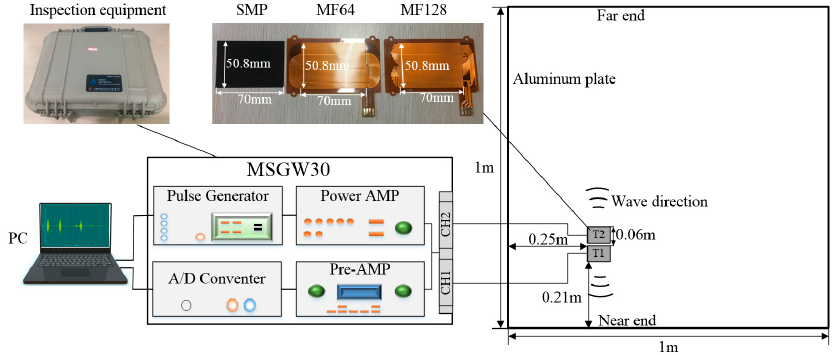
Figure 13. The diagram of the experiments for transducer improvement with the SMP.